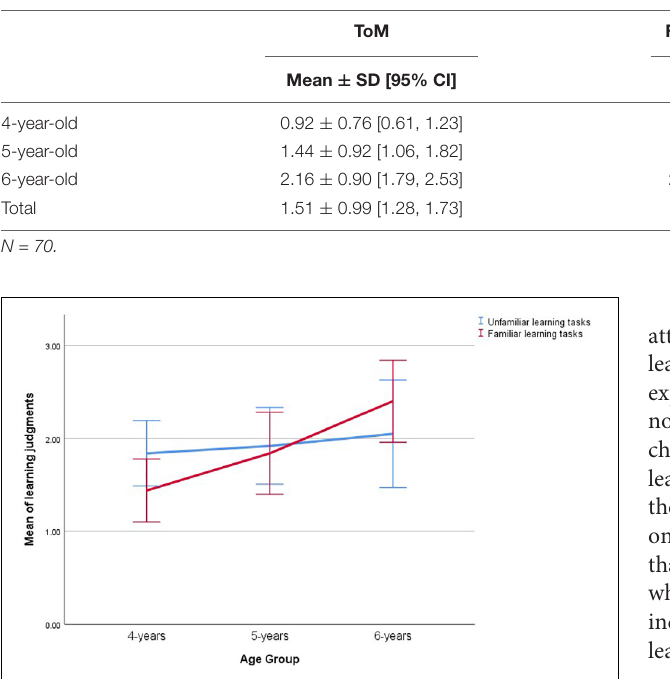
when they were familiar with the learning contents. Six-year-